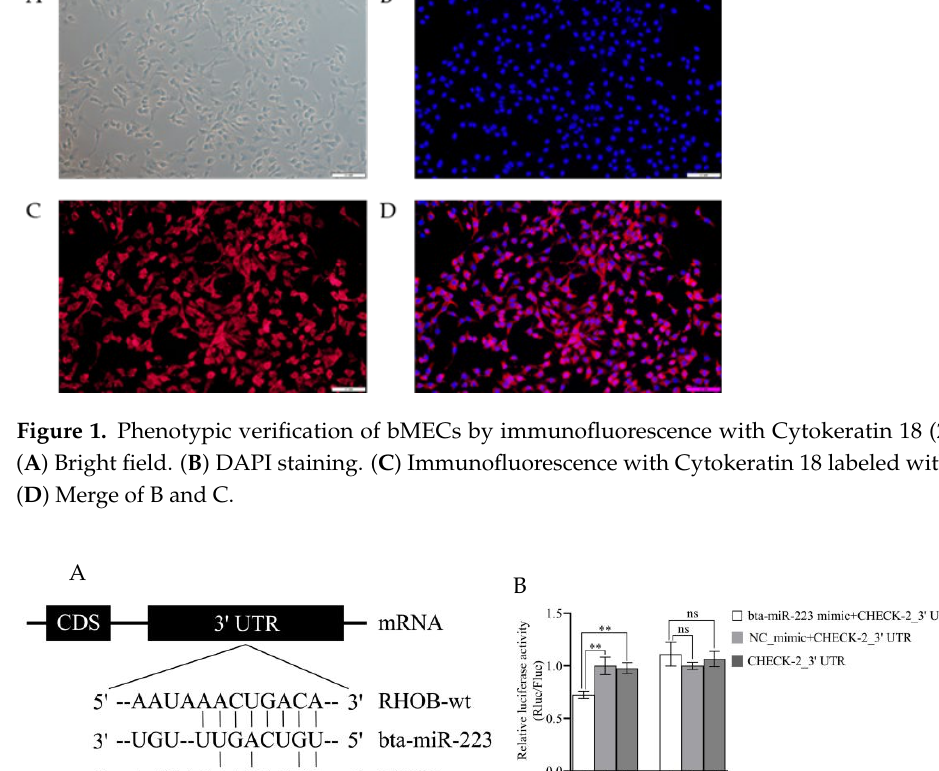
Figure 1. Phenotypic verification of bMECs by immunofluorescence with Cytokeratin 18 (200×). ( A ) Bright field. ( B ) DAPI staining. ( C ) Immunofluorescence with Cytokeratin 18 labeled with Cy3. ( D ) Merge of B and C.